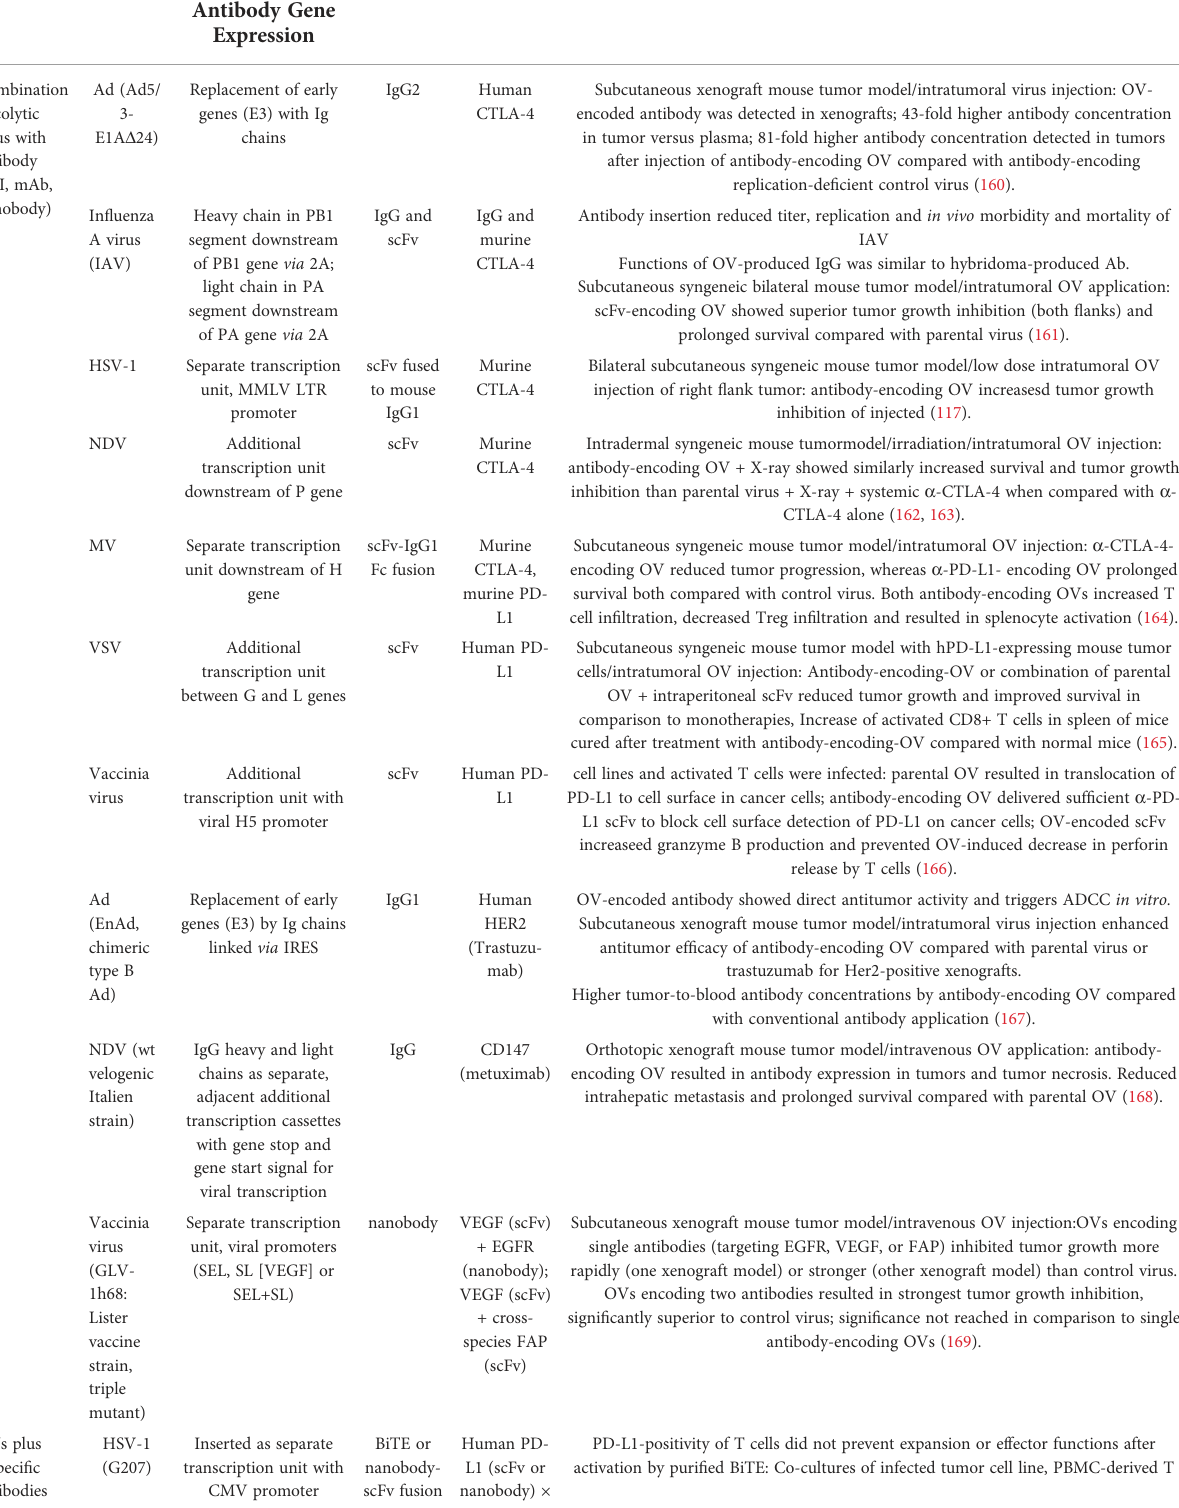
TABLE 4 Summary of combination therapies with oncolytic viruses and other immunotherapeutic